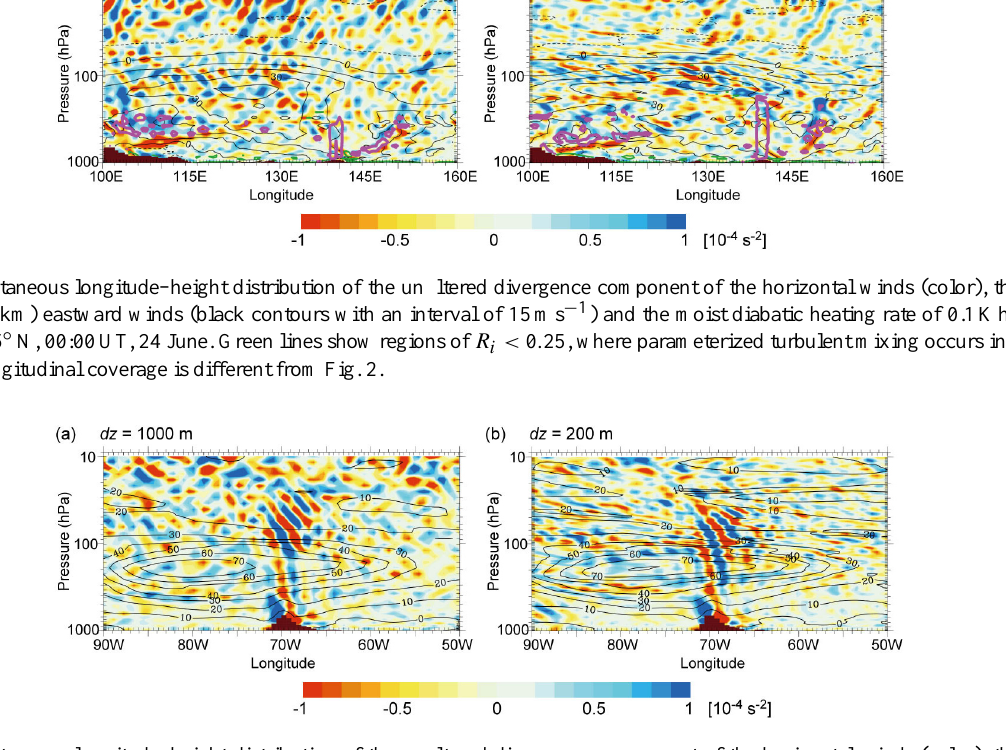
Figure 4. Instantaneous longitude–height distribution of the unfiltered divergence component of the horizontal winds (color), the low-pass filtered ( > 1000km) eastward winds (black contours with an interval of 10ms − 1 ) at 30 ◦ S, 06:00UT, 27